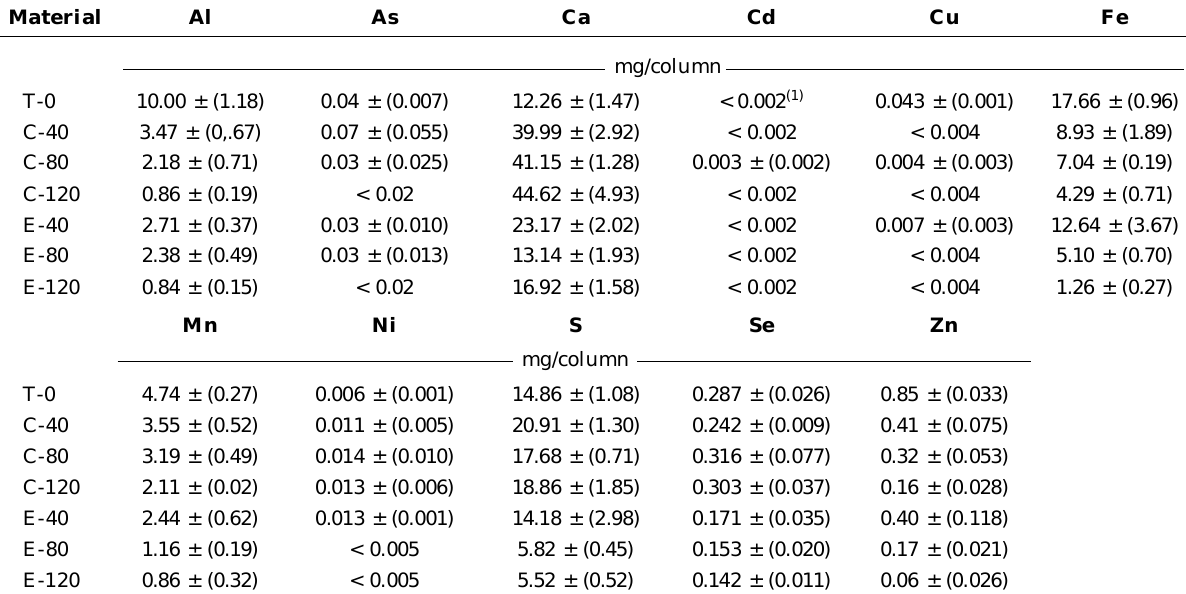
Table 6. Average contents of Al, As, Ca, Cd, Cu, Fe, Mn, Ni, S, Se and Zn leached in 262 days, from columns treated with increasing doses of limestone or steel slag, followed by their respective standard